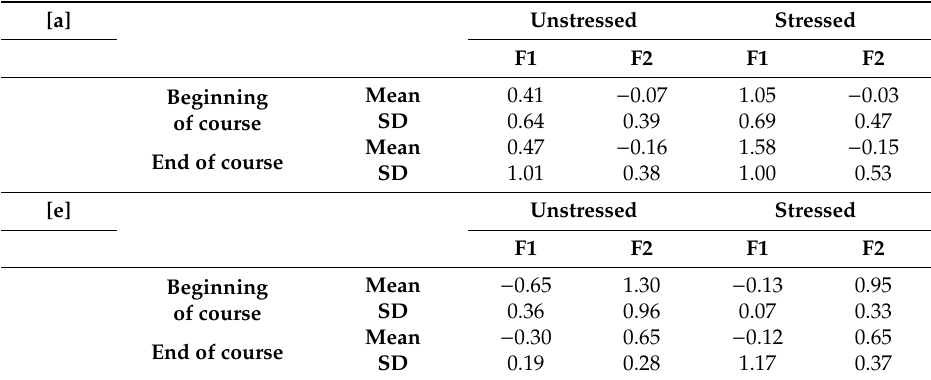
Table 6. Mean Lobanov-normalized F1 and F2 values for Informant D.